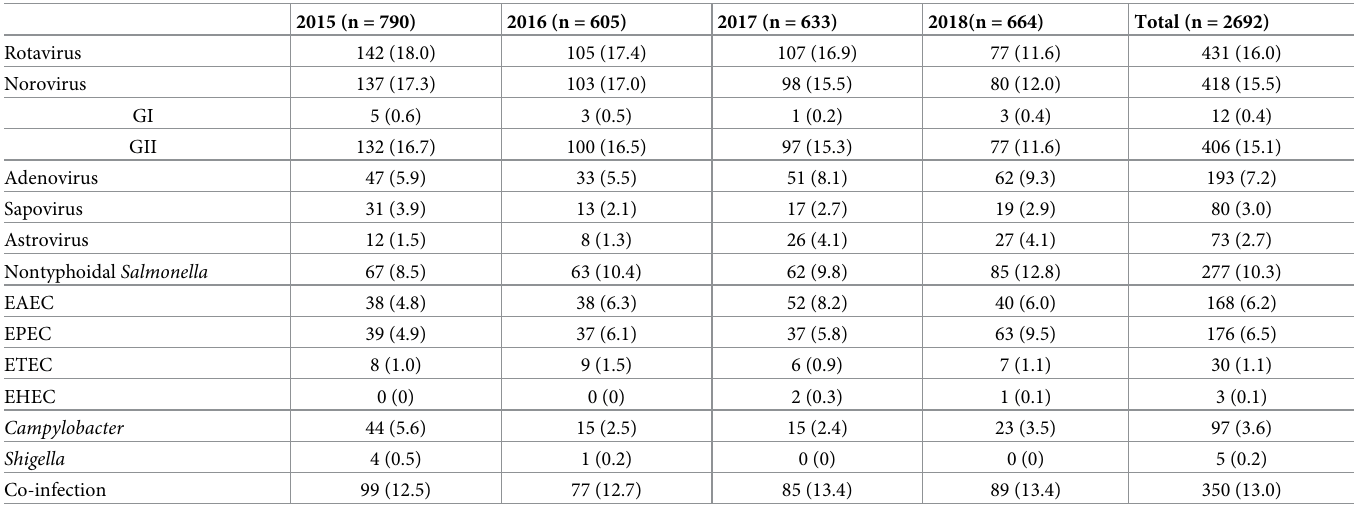
Table 2. The distribution of enteric pathogens in Shanghainese children with acute diarrhoea from 2015 to 2018 [n